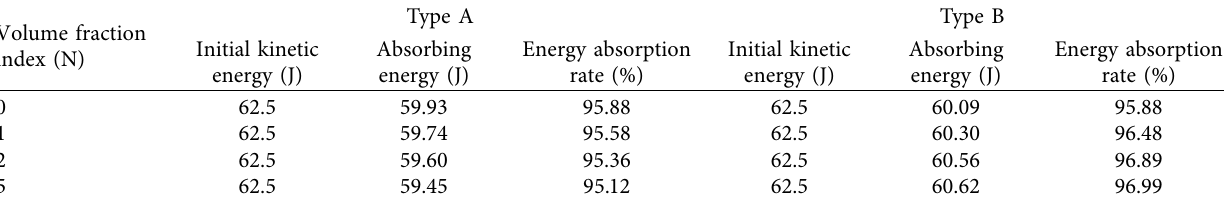
Table 6: Energy absorption capacity with different volume fraction